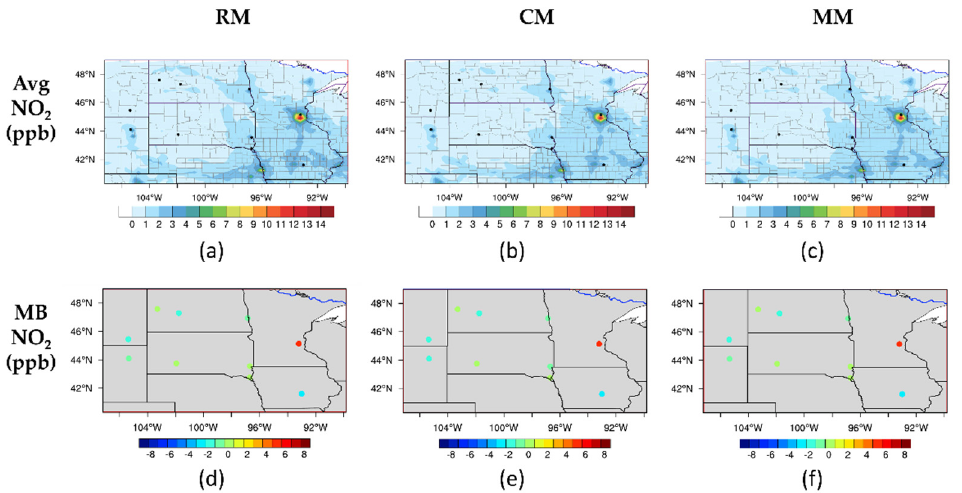
Figure 6. Monthly average of predicted hourly NO 2 concentrations (ppb) during July 2010. Model predictions for ( a ) RACM-MADE/SORGAM (RM), ( b ) CBMZ-MOSAIC (CM), and ( c ) MOZART- MOSAIC (MM). Mean bias of model predictions against observations for ( d ) RM, ( e ) CM, and ( f )